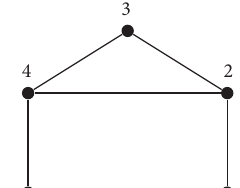
Figure 2: Quasiregular graph of Z